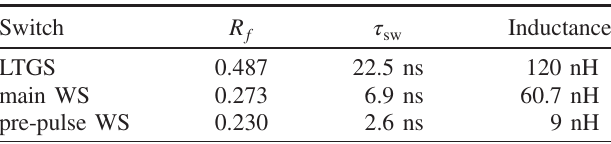
TABLE II. Typical switch parameter values for a shot config- ured with an 85 kV Marx charge voltage. The inductance values represent the arc inductance (i.e., the increase in inductance over a shorted switch). The LTGS resistance and inductance have a small dependence on switch voltage. The water switch inductance and resistance vary with the electrode gap